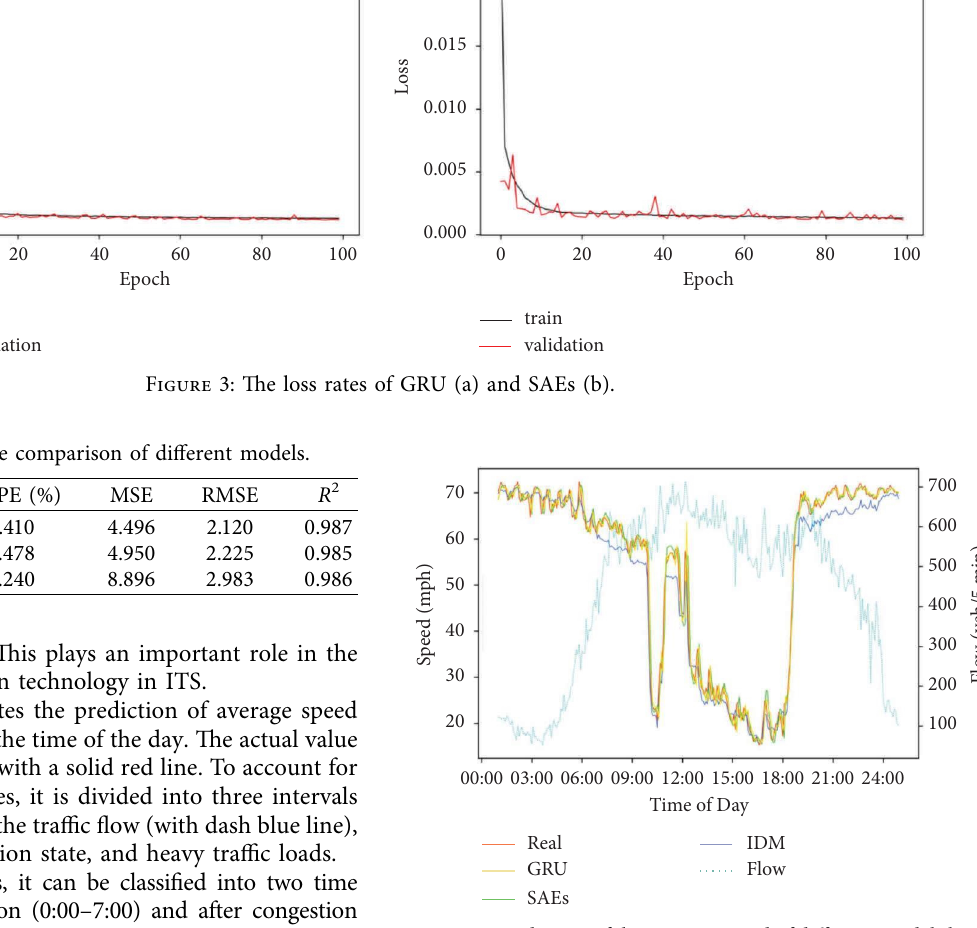
Figure 4: Prediction of the average speed of diferent models by the time of